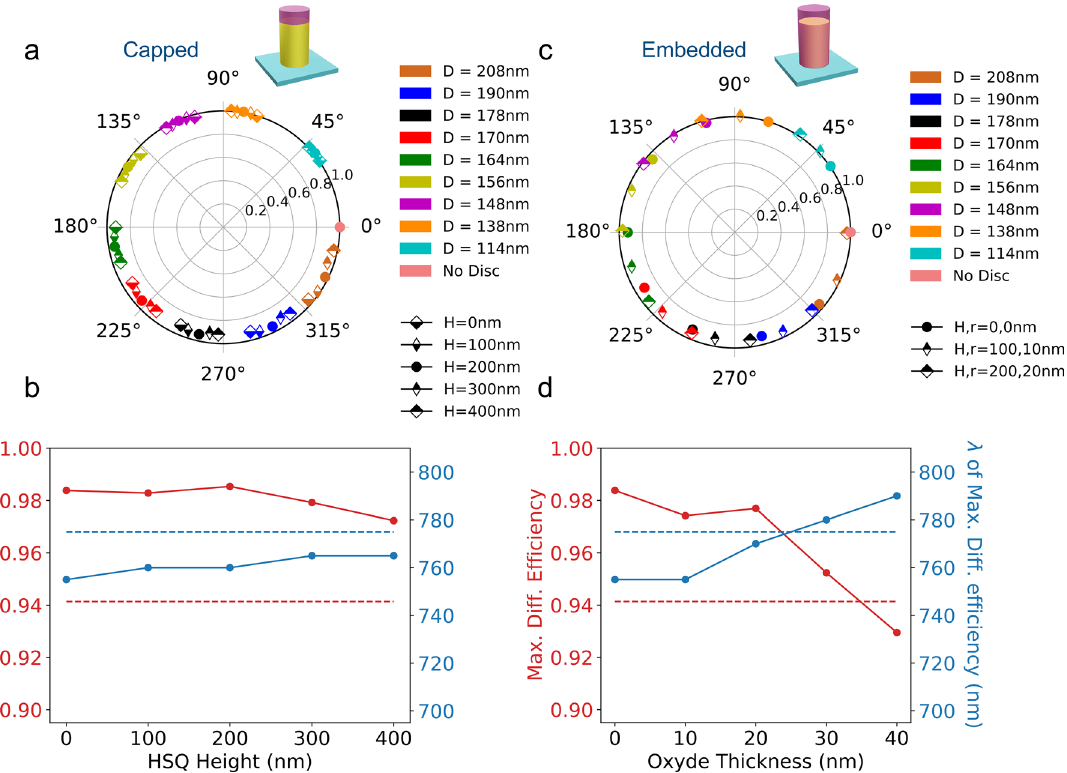
Figure 7. ( a ) Transmission and dephasing induced by an array of silicon nanocylinders on a normally incident (cid:31) = 750 nm plane wave as a function of the thickness of a residual resist layer for the ten selected geometries. ( b ) Diffraction efficiency and wavelength of max. diffraction efficiency as a function of the thickness of a remaining resist layer. ( c ) Transmission and dephasing induced by an array of silicon nanocylinders on a normally incident (cid:31) = 750 nm plane wave as a function of the thickness of a remaining resist layer and lateral oxyde layer for the ten selected geometries. ( d ) Diffraction efficiency and wavelength of max. diffraction efficiency as a function of the thickness of a remaining resist layer and lateral oxyde layer . The red (resp. blue) dotted lines show the measured values of maximum diffraction efficiency and corresponding wavelength. In Figures c and d, the capping thickness is taken ten times larger than the thickness of the lateral oxyde